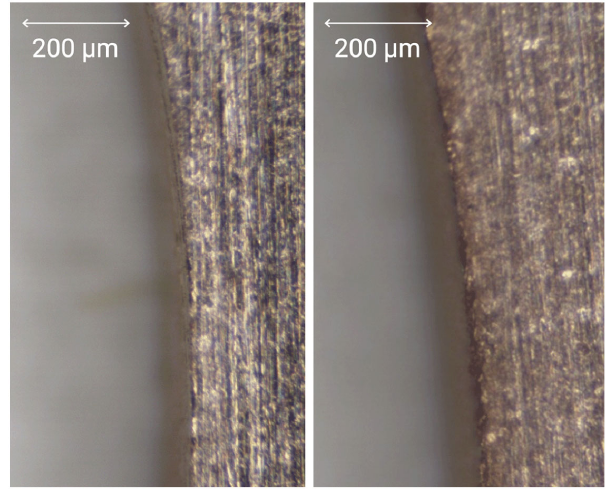
FIG. 27. Visible microscope images of the edges of plates before (left) and after (right) treatment with Citranox bath procedure. Edges are visibly rounded by the